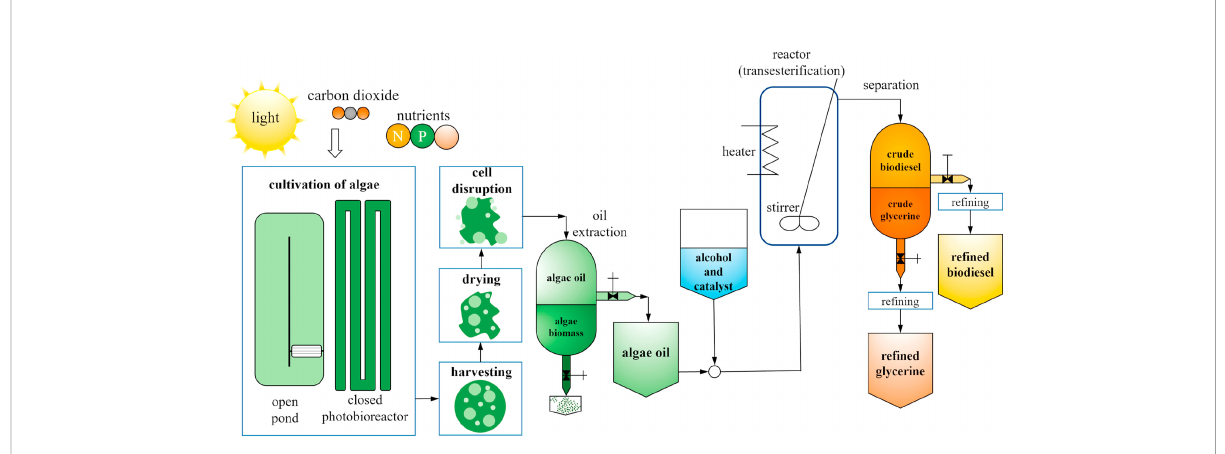
FIGURE 6 The fl owchart of production from microalgae to biodiesel. (reproduced with permission from (Cos ̧ gun et al.,